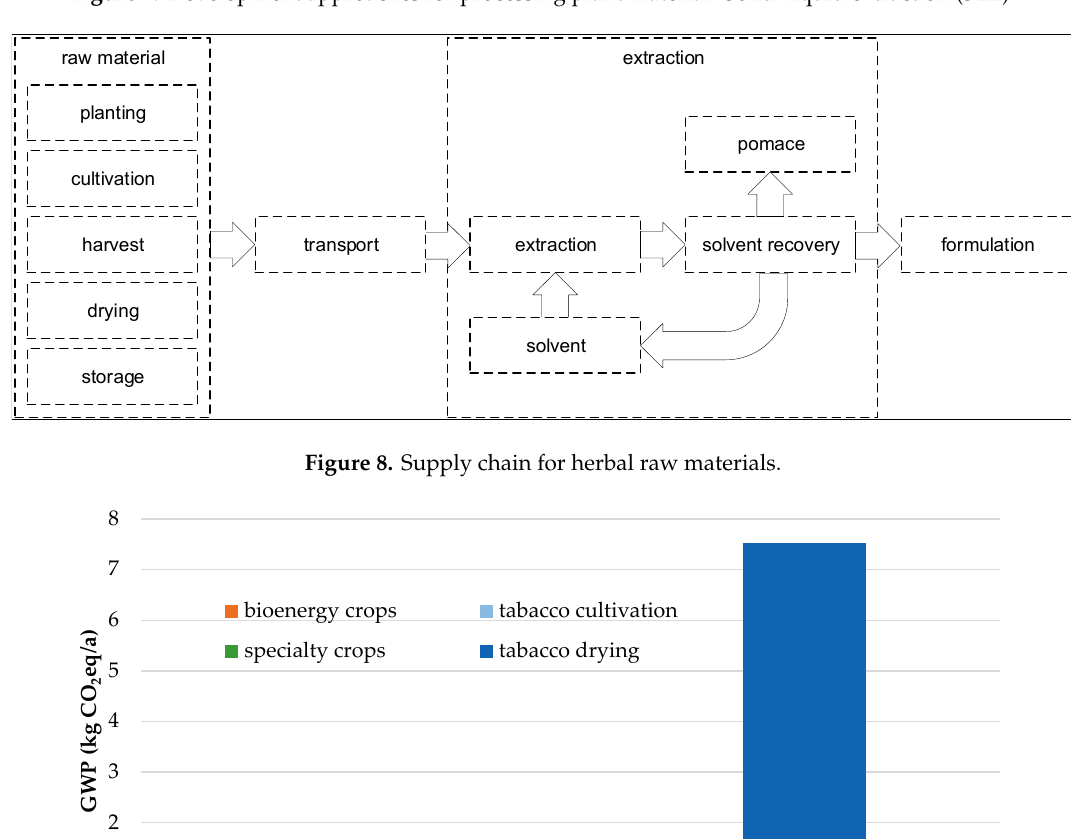
Figure 7. Development approaches for processing plant material. Solid–liquid extraction (SLE).